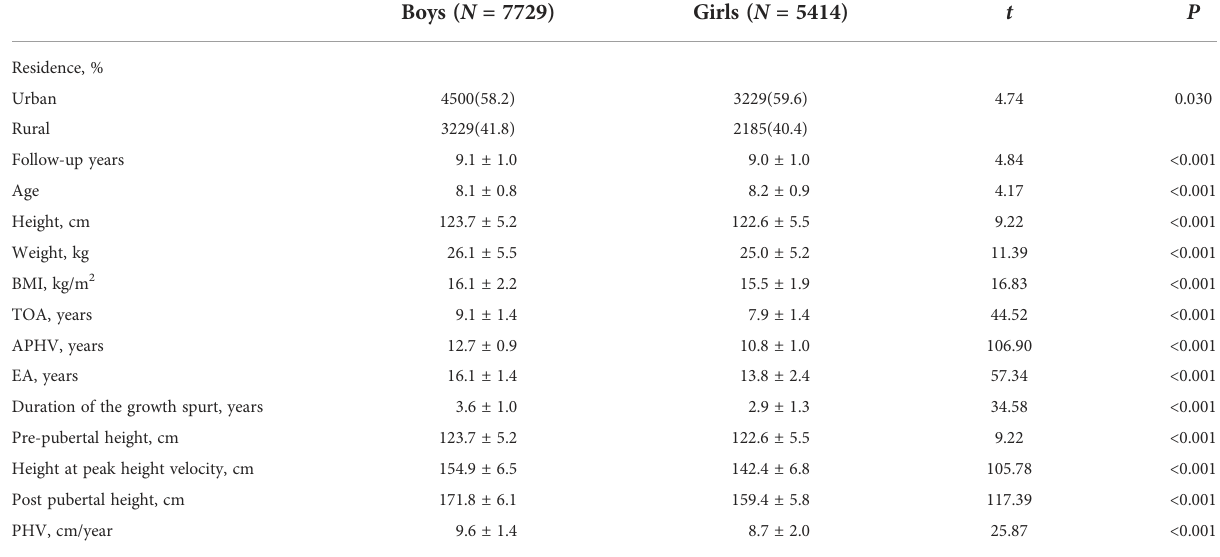
TABLE 1 Characteristics for participants by